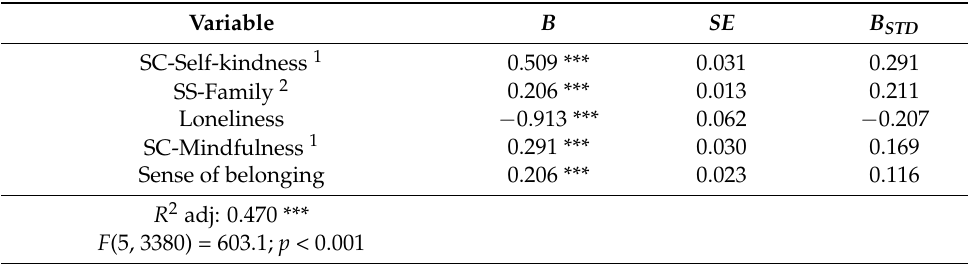
Table 5. Linear regression models for peace and